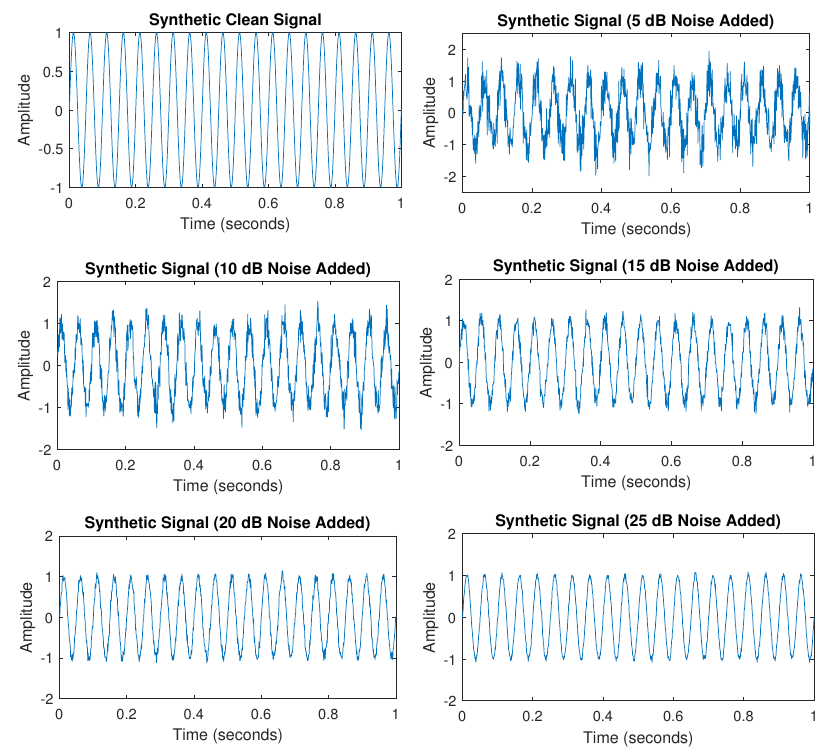
Figure 3. Synthetic clean signal and the signals with the addition of several degrees of Gaussian white noise.